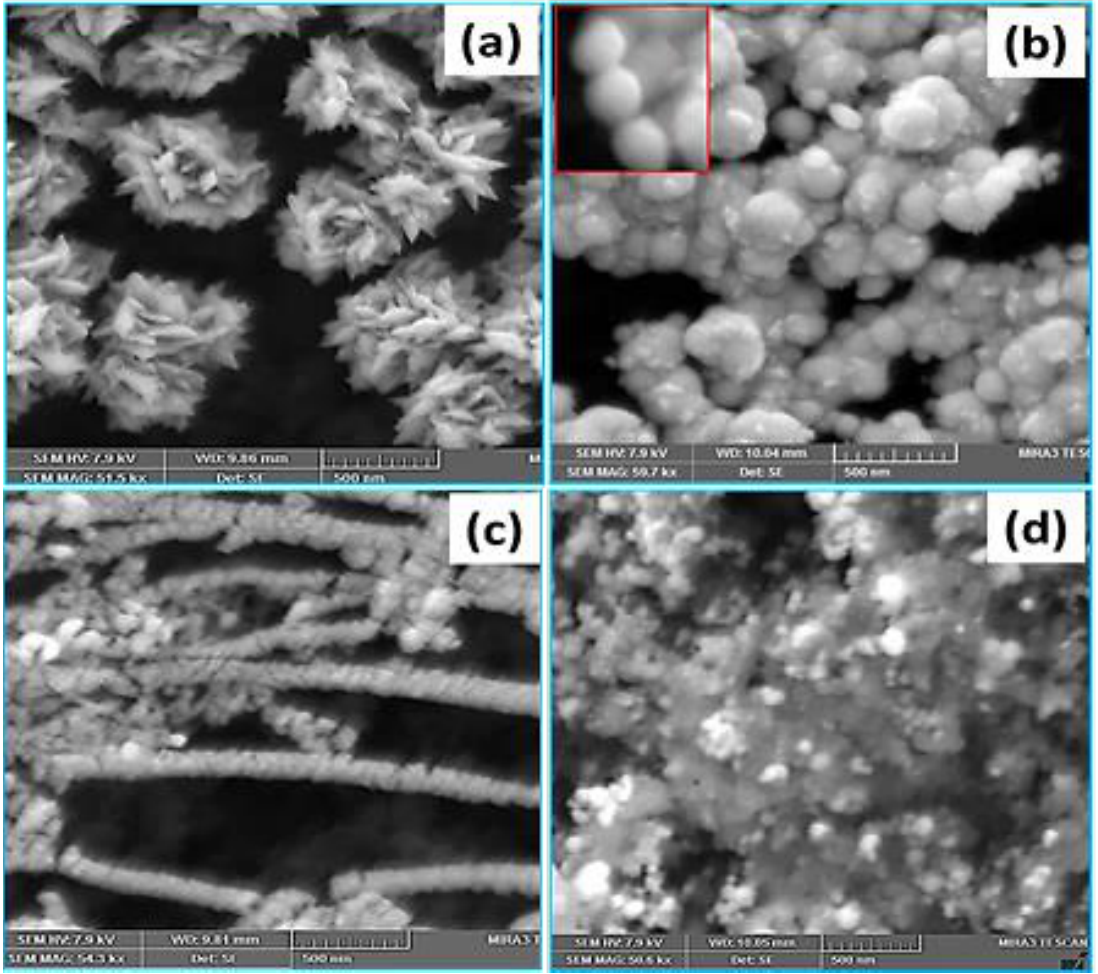
Figure 5. FE-SEM images of Pt deposited with influence of pH: ( a ) pH 1, ( b ) pH 3, ( c ) pH 7, and ( d ) pH 10. ( b —inset shows pellet-shaped globular morphology of deposited Pt)